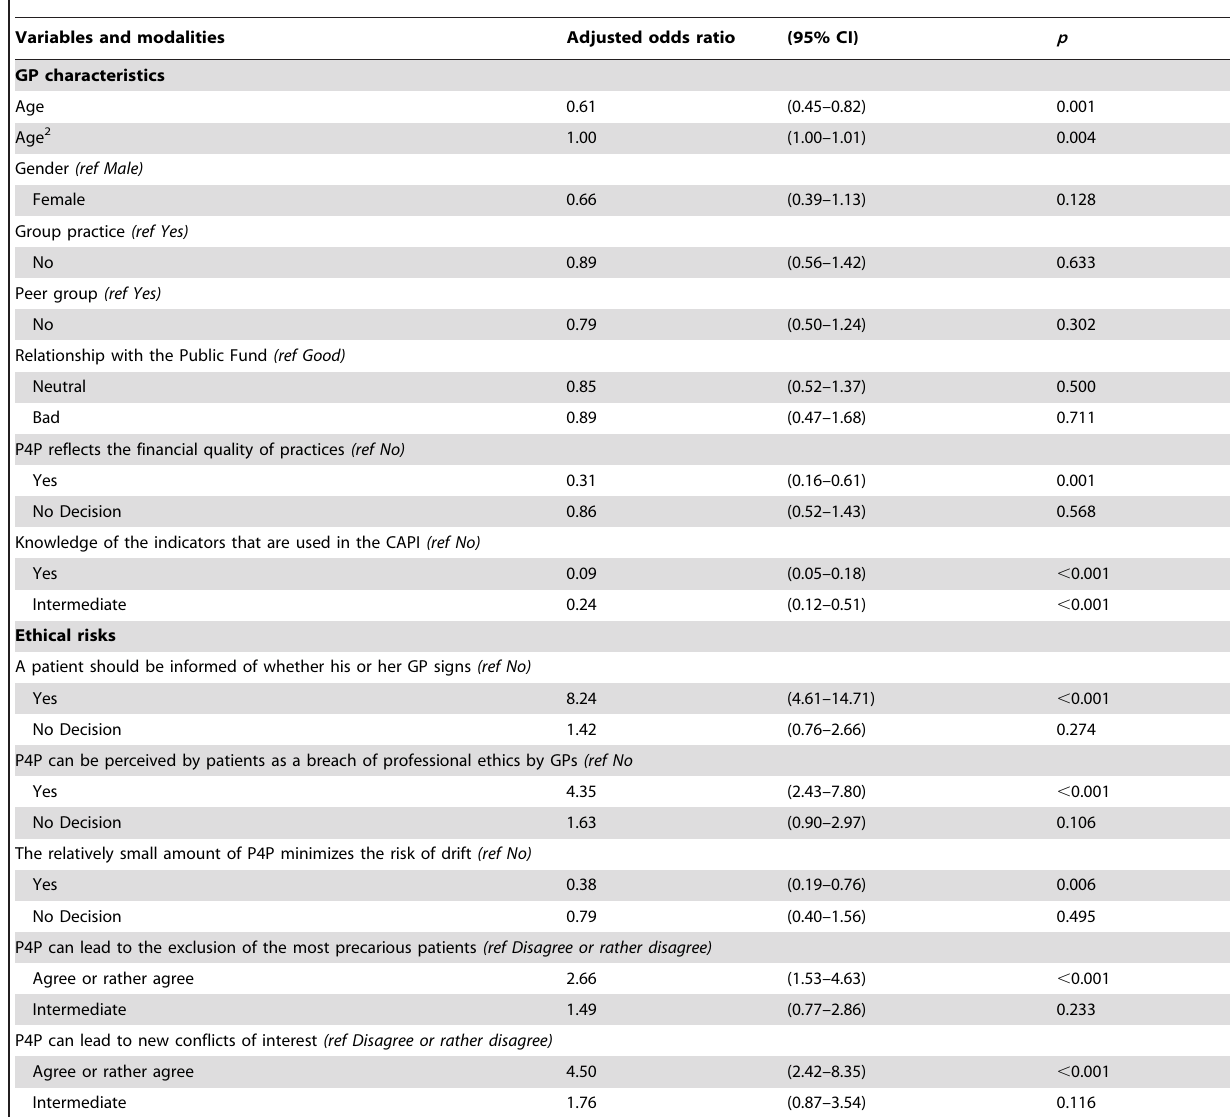
Table 4. Multivariate analysis: variables significantly associated with the CAPI